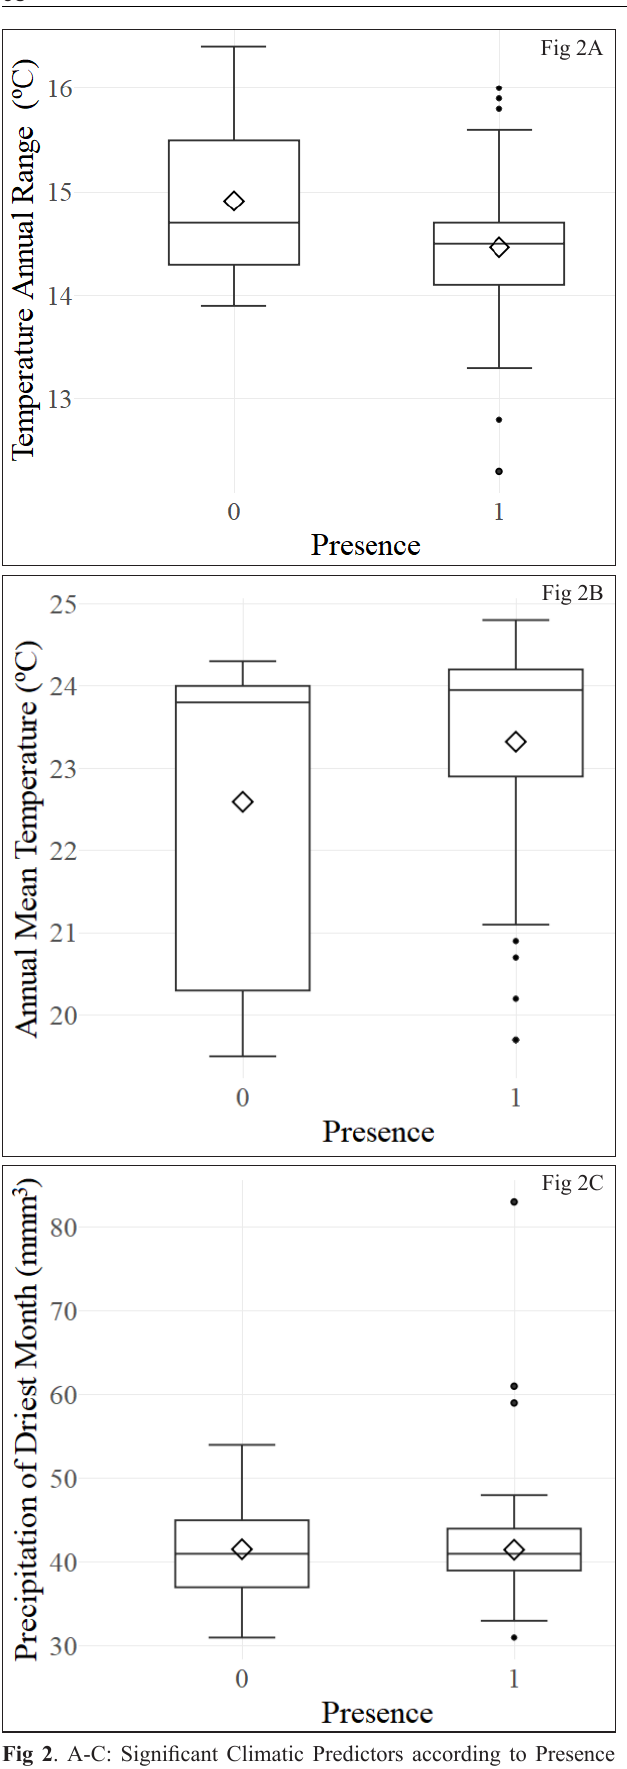
Fig 2 . A-C: Significant Climatic Predictors according to Presence and Absence